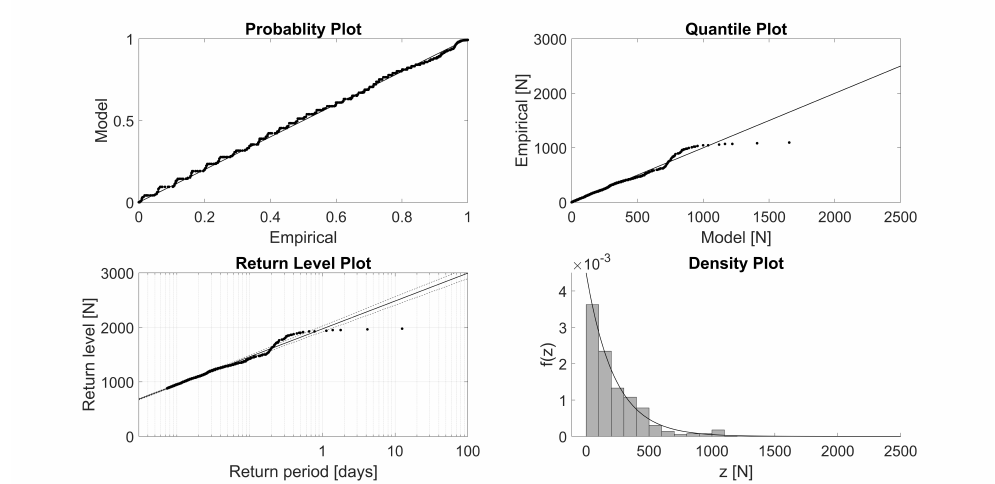
Figure 9. Diagnostic plots for ED fit to the force data with the threshold of 880 N without declustering. In the return level plot, the dashed lines show the lower and upper bound of 95% confidence interval. In the density plot, z corresponds to forces above threshold